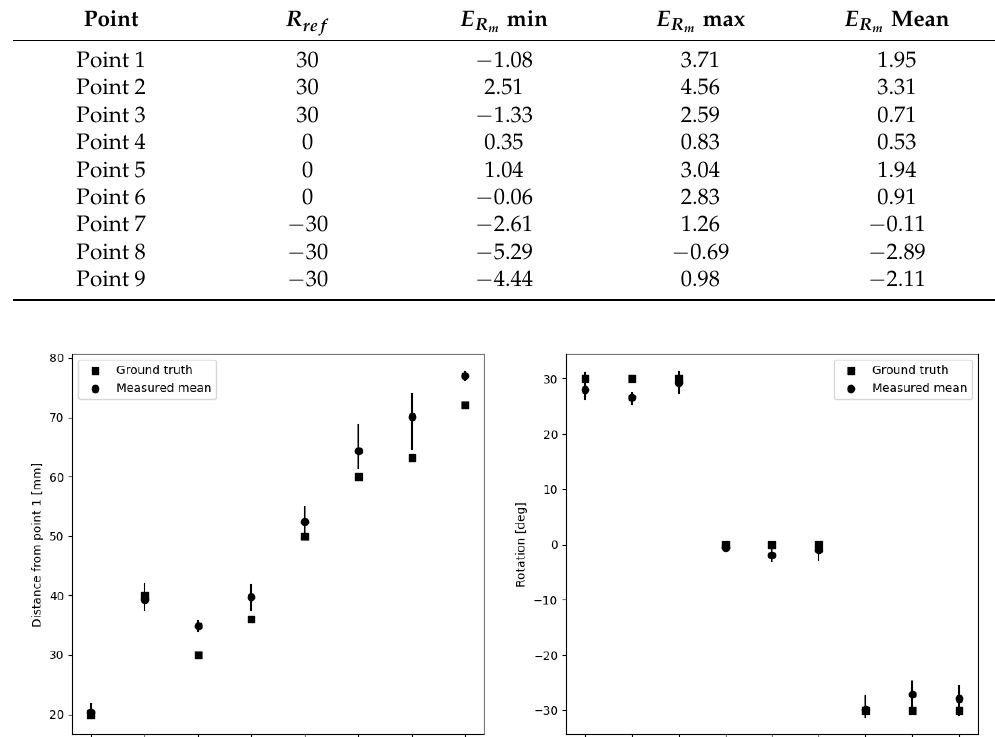
Table 3. Results of the assessment of the human factor error in rotation. R ref is the reference rotation about the horizontal x axis, while E R are the measured rotation errors about the x axis. All values m are in degrees.